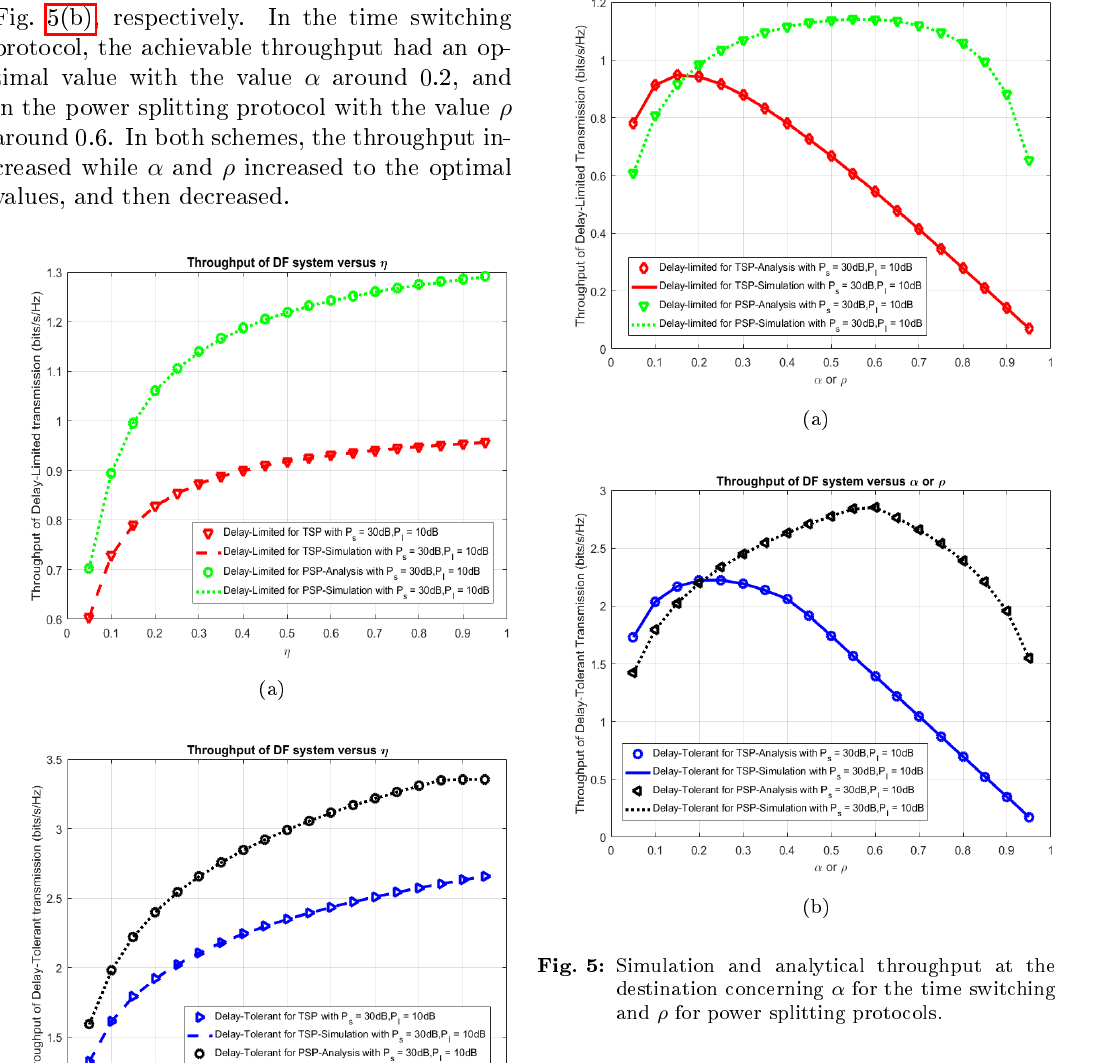
Fig. 5: Simulation and analytical throughput at the destination concerning α for the time switching and ρ for power splitting